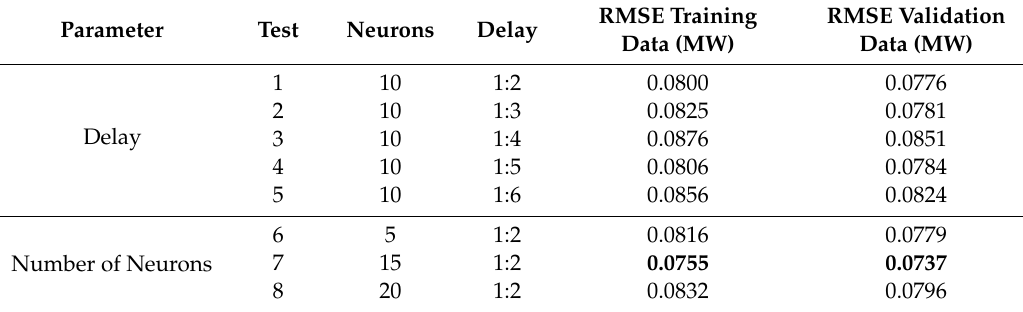
Table 6. Structure design test for option 4.